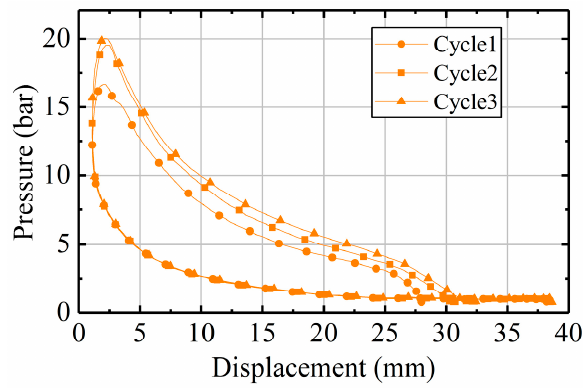
Figure 23. The tested in-cylinder pressure (fixed generated